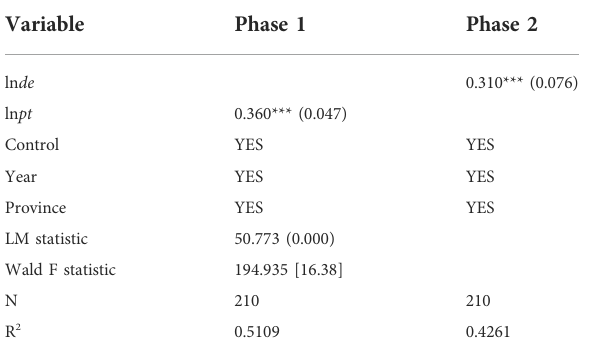
TABLE 10 2SLS test